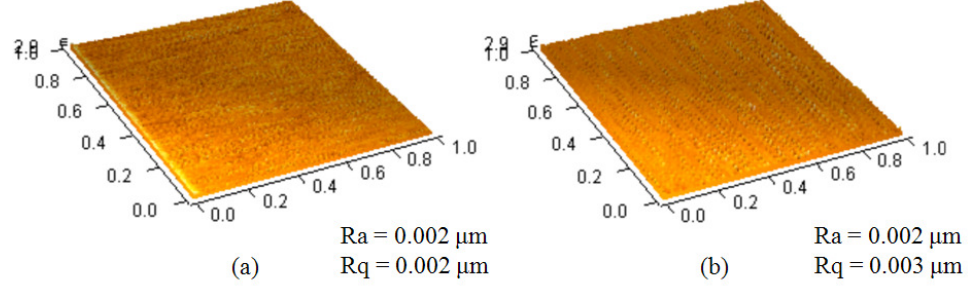
Figure 3. Atomic force microscope (AFM, OBJ-204C, ITRI of Taiwan) images of the SU-8 photoresist ( a ) before and ( b ) after UV/ozone treatment. All images were taken at a scan size of 1 × 1 µ m 2 with a 128 × 128 pixel 2